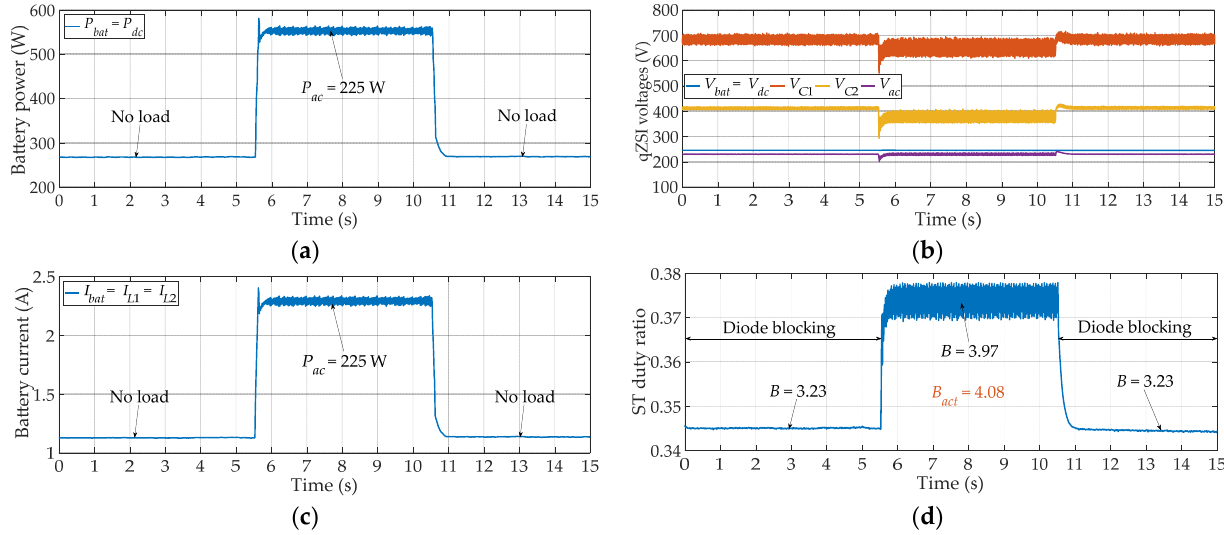
Figure 14. Dynamic responses to load perturbations during no-wind operation: ( a ) battery power; ( b ) qZSI voltages; ( c ) battery current; ( d ) shoot through (ST) duty ratio.